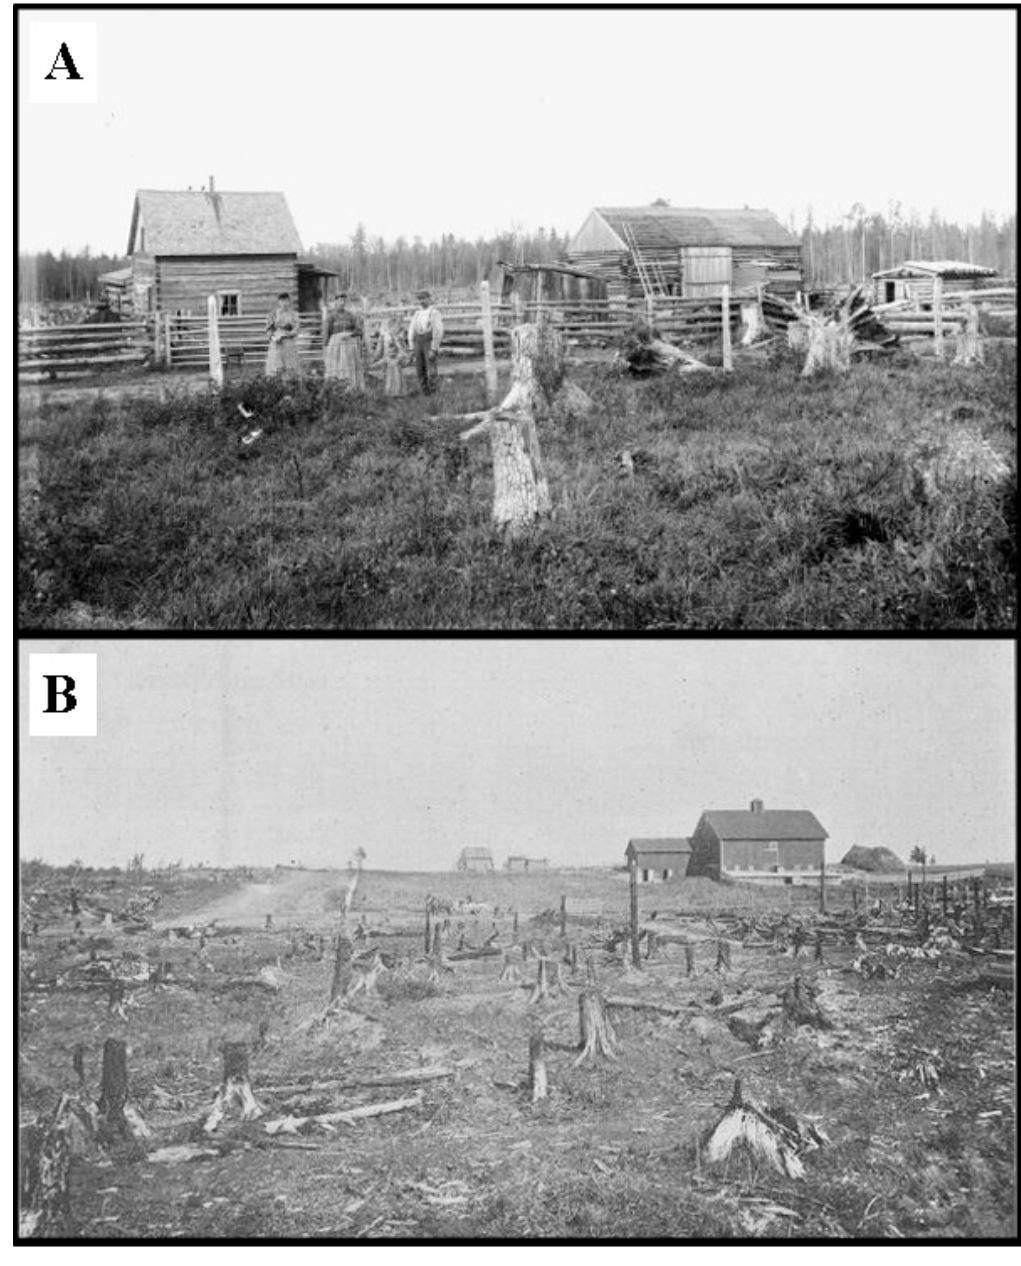
Fig. 9. Promotional materials depicting farmstead development in the northern Wisconsin cutover region.